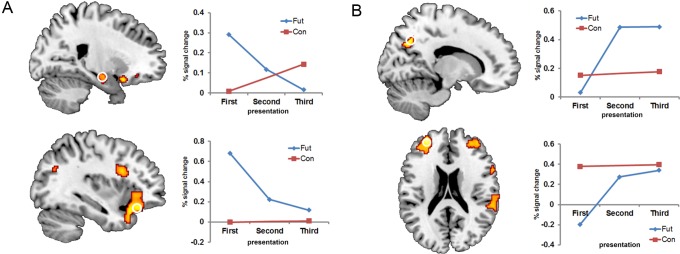
Results from contrast analyses.(A) Regions from the interaction analysis in which fMRI signal decreased across repetitions for the future condition only: right hippocampus (xyz 22 −10 −14, top panel) and left inferior frontal gyrus (−36 28 −16, bottom panel), and associated percent signal change data for future and control conditions (First =  First
Future and time1
Control conditions; Second = Second
Future; Third =  Third
Future and time2
Control conditions). These regions were also evident in the contrast of First>Second>Third (see Table 3). (B) Regions from the interaction analysis in which fMRI signal increased across repetitions for the future condition only: right precuneus (14 −64 38, top panel) and left anterior prefrontal cortex (−30 52 20, bottom panel) with associated percent signal change data. These regions were also evident in the contrast of Third>Second>First (see Table 3). Activity is shown at puncorrected <.0001 overlaid on a standard anatomical template; all peak activations survived a corrected threshold of pFWE <.05; see Table 3. Note that error bars are not included as these plots are for descriptive purposes only [54].